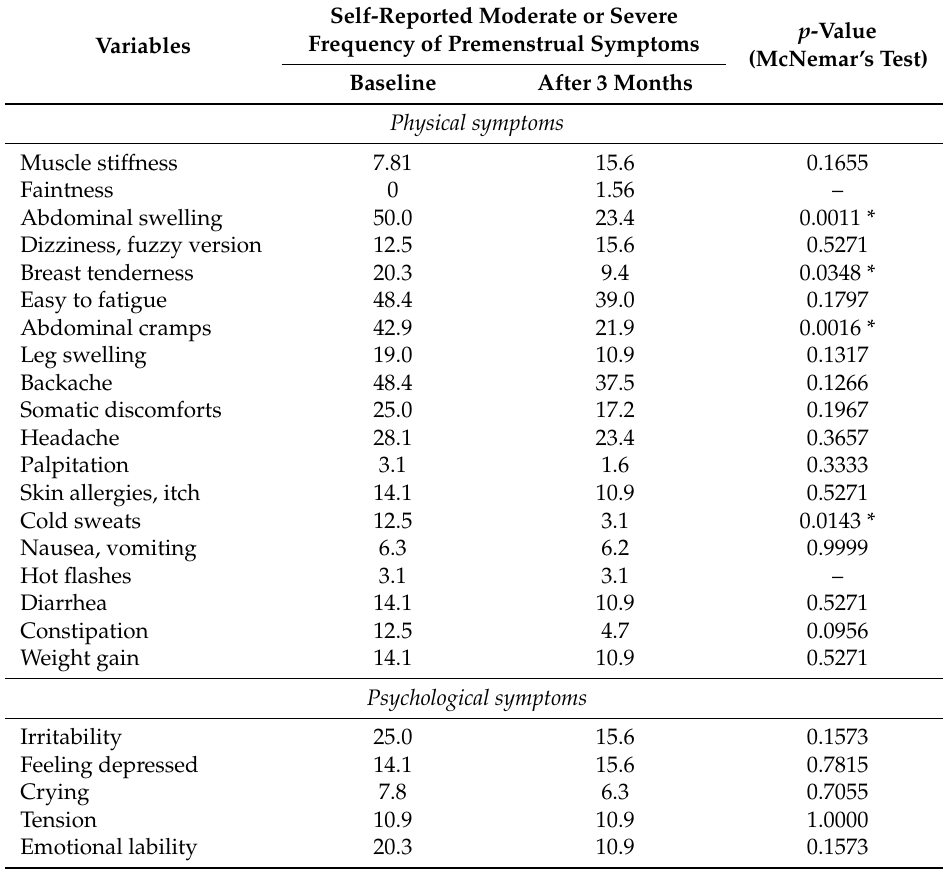
Table 3. Comparison of self-reported moderate or severe frequency of premenstrual symptoms among study participants and exercise habit by moderate or severe symptoms.